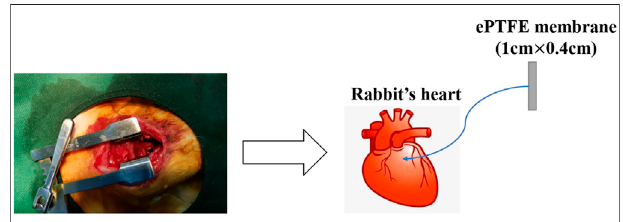
FIGURE 1 | Surgical diagram of expanded polytetra fl uoroethylene (ePTFE) implantation site.